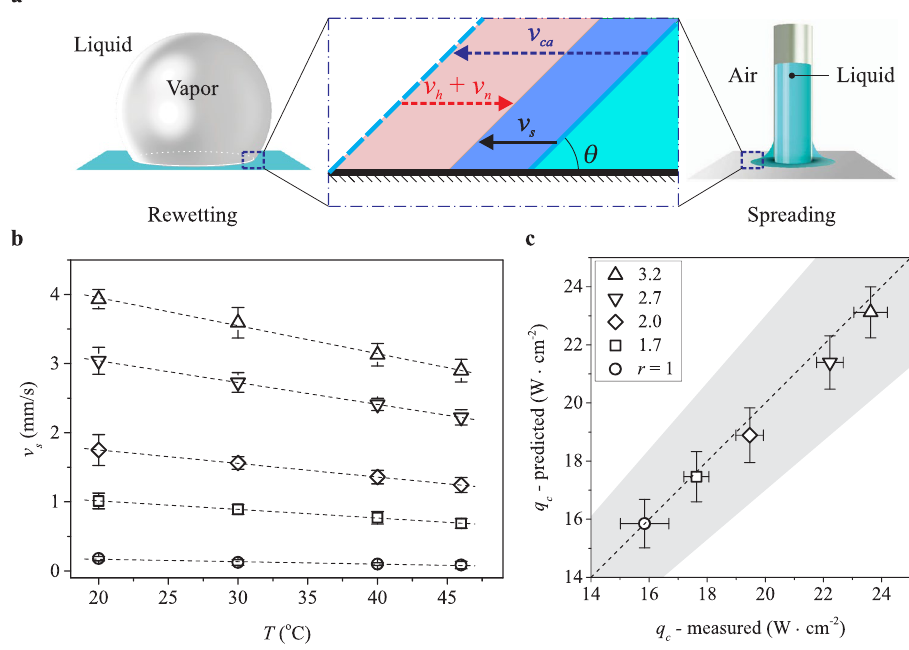
Figure 3. ( a ) Schematics showing similarities between the rewetting process in pool boiling (left panel) and the spreading process (right panel) from a capillary, in particular at the three-phase contact line (highlighted in the middle panel). ( b ) Apparent spreading velocity v s of FC-72 on different substrates over a range of temperature from 20 °C to 46 °C. ( c ) Critical heat flux q c predicted using Eqn. 2 versus the measured values for smooth substrate ( r = 1) and nanopillar substrates. The uncertainty for the predicted heat flux comes from that of the spreading velocity measurements. The shaded area indicates a 15% deviation from the measured